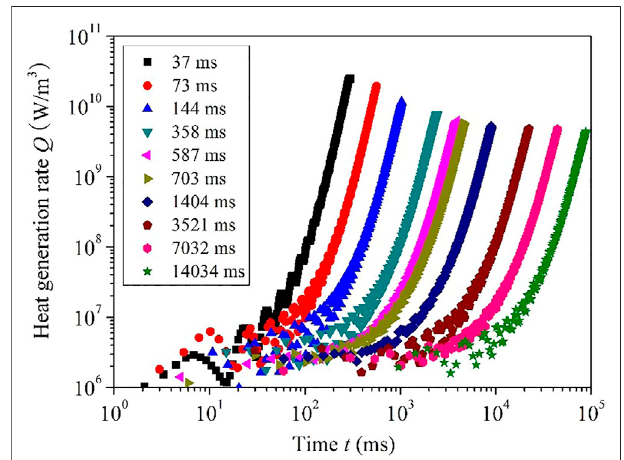
FIGURE 4 | The exponential heat generation rate for the twisted plate with various heat generation periods.